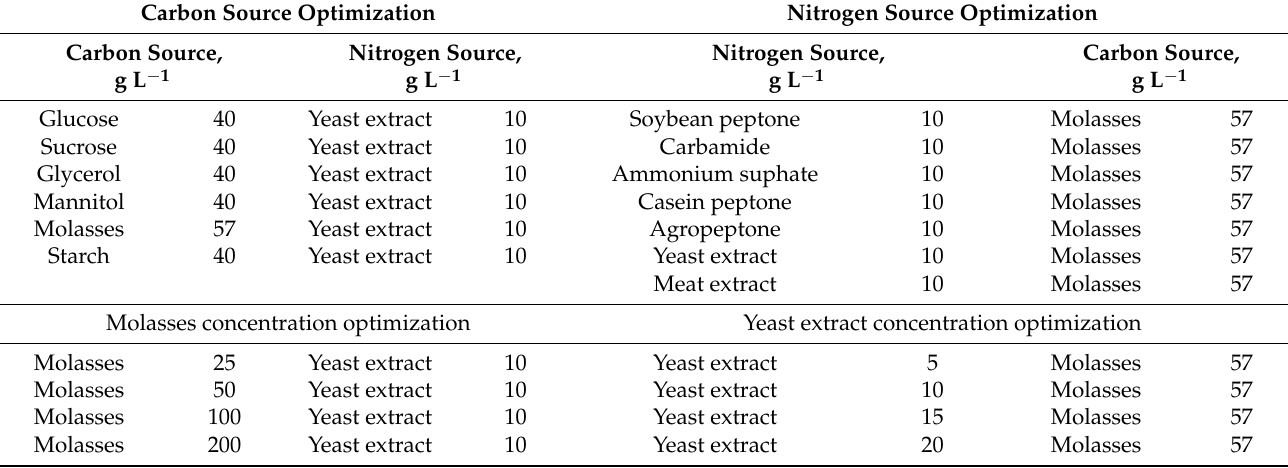
Table 1. Nitrogen and carbon source